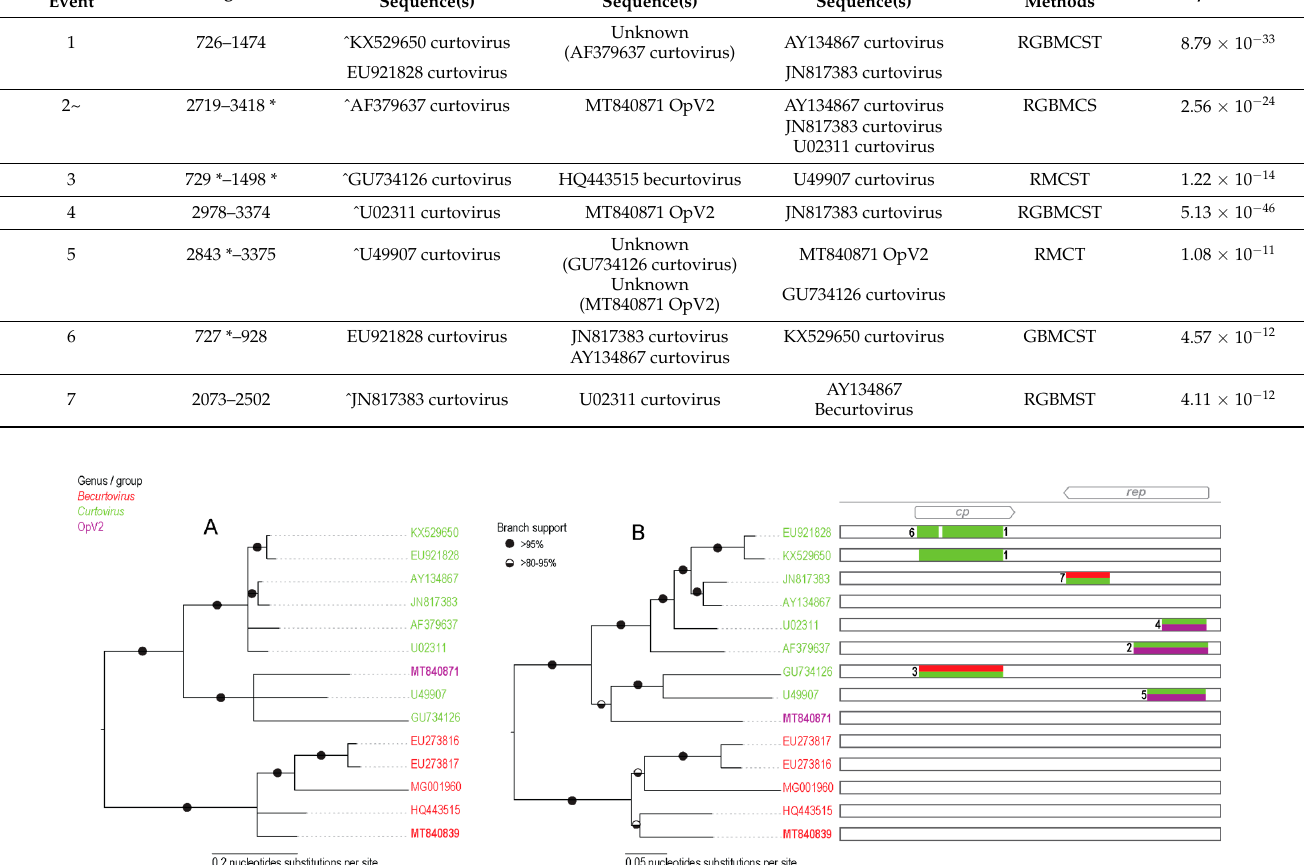
Figure 5. ( A ) Neighbor-joining phylogenetic tree of the OpV2 and becurtovirus representative sequences, together with representatives from the genera Becurtovirus and Curtovirus . Branches with <60% bootstrap branch support have been collapsed and the tree is midpoint-rooted. ( B ) Maximum-likelihood (ML) phylogenetic tree of the Opv2 and becurtovirus representative sequences, together with representatives from the genera Becurtovirus and Curtovirus with recombination regions removed. Branches with <60% bootstrap support have been collapsed and the tree is midpoint-rooted. Graphical representation of each genome, representing the recombination event with the breakpoint location within the OpV2 genome for reference, which is color coded according to the genera of the major and minor parent sequences of each event. In bold are the two sequences that represent OpV2 and Opuntia becurtovirus.